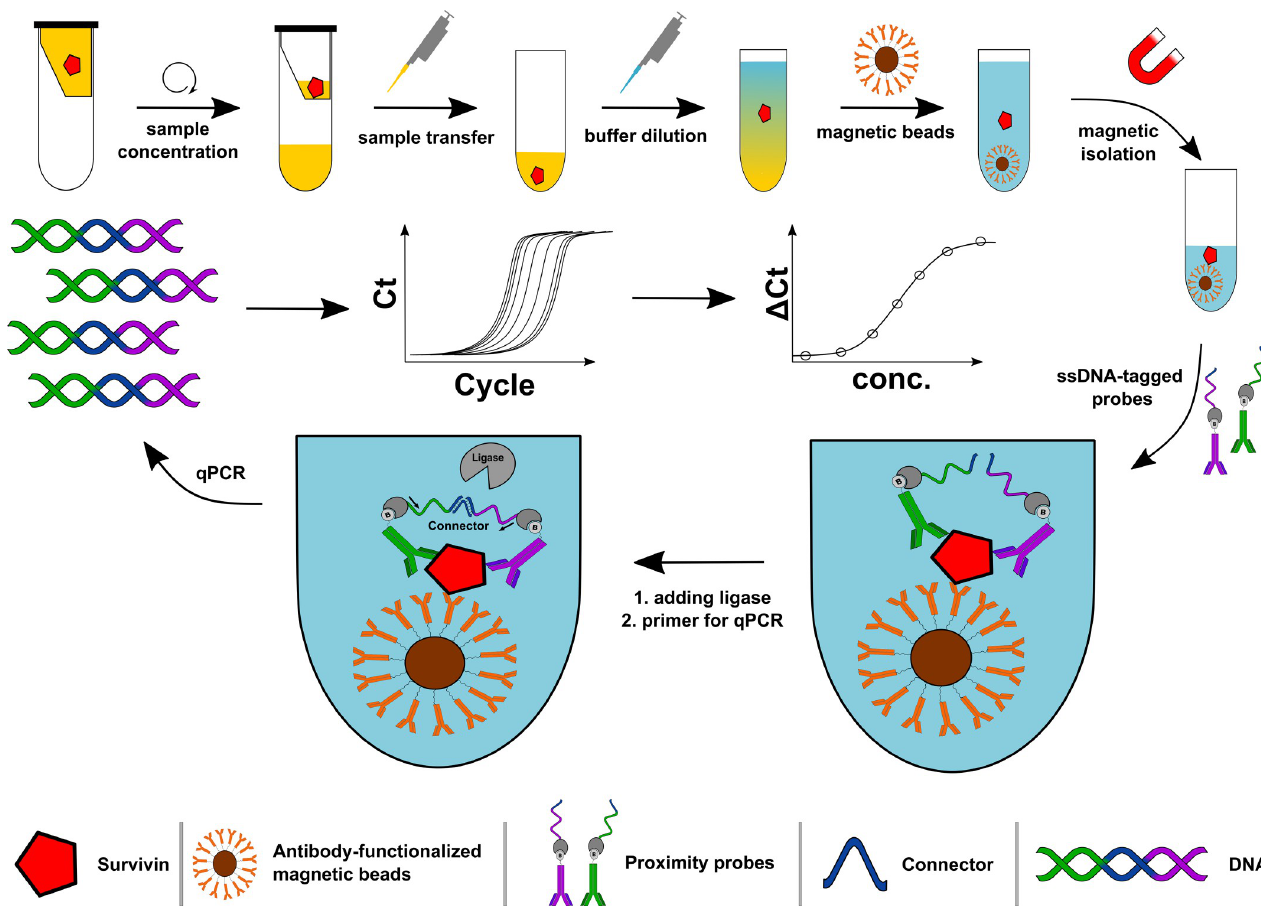
Fig 2. Workflow for spPLA detection of survivin in urinary samples. After urine concentration the remaining sample is diluted in buffer for pH neutralization. After sequential binding of survivin antibody-functionalized magnetic beads and proximity probes, DNA-strands come into close proximity. A connector allows the ligation, thereby forming a new chimeric DNA strand. Real-time PCR and further analysis allow protein quantification.